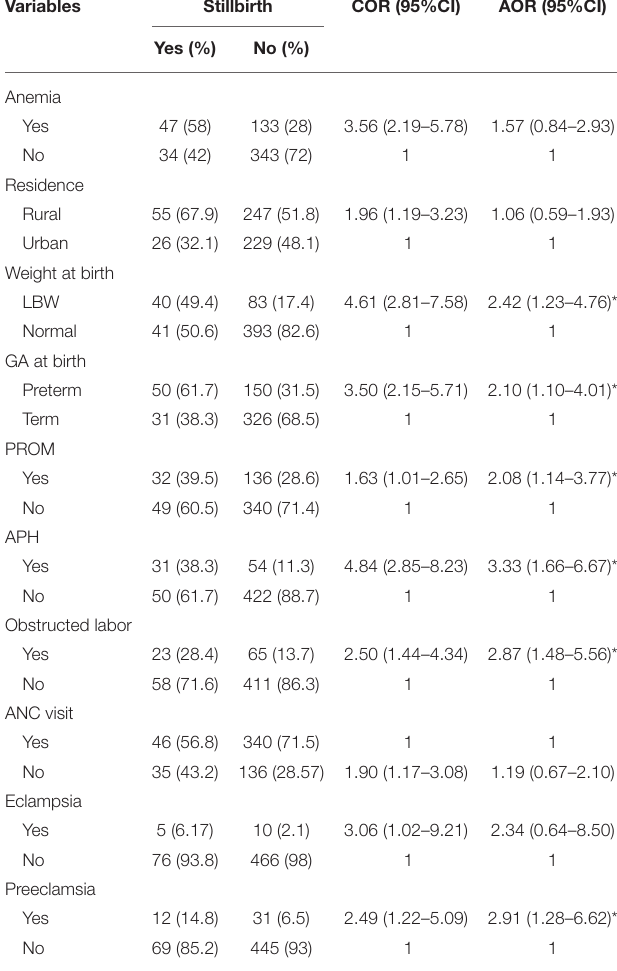
TABLE 5 | The multivariate analysis of factors associated with a stillbirth at Hiwot Fana Specialized University Hospital, Harar, Eastern Ethiopia, 2018/2019 ( n =